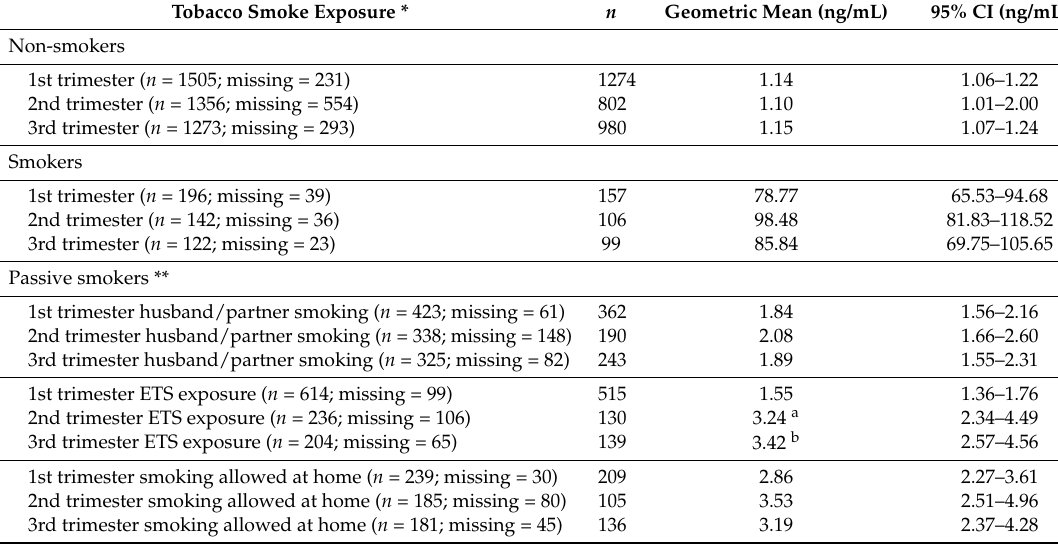
Table 1. Saliva cotinine concentrations according to self-reported active and passive smoking status during pregnancy.